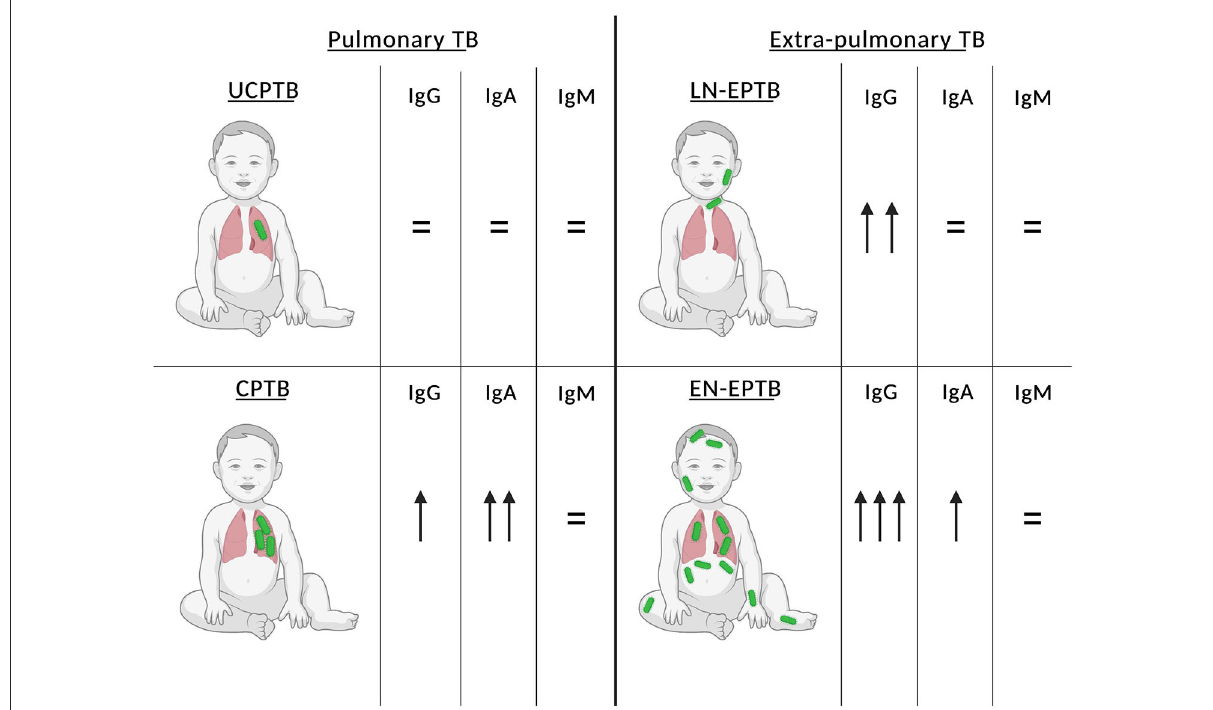
FIGURE3 Patterns of serum IgG, IgA, and IgM levels at diagnosis in the four TB study groups. Median serum Ig levels in each TB study group were compared with median levels of sex- and age-matched reference values. Equal sign or upward arrows were assigned according to the difference between median values as follows: difference 0–0.5 SD (equal sign), 0.5–1 SD (one upward arrow), 1–2 SD (two upward arrows), and > 2 SD (three upward arrows). TB, tuberculosis; SD, standard deviation; UCPTB, uncomplicated pulmonary TB; CPTB, complicated pulmonary TB; LN-EPTB, lymph node extra-pulmonary TB; EN-EPTB, extra-nodal extra-pulmonary